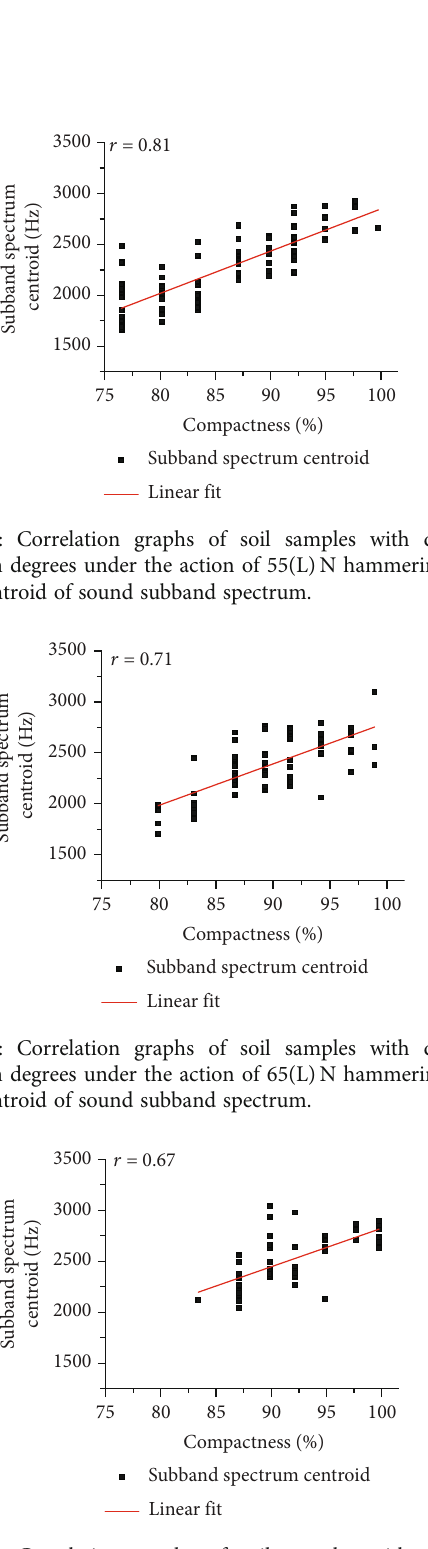
Figure 13: Correlation graphs of soil samples with di ff erent compaction degrees under the action of 75(L) N hammering force and the centroid of sound subband spectrum.